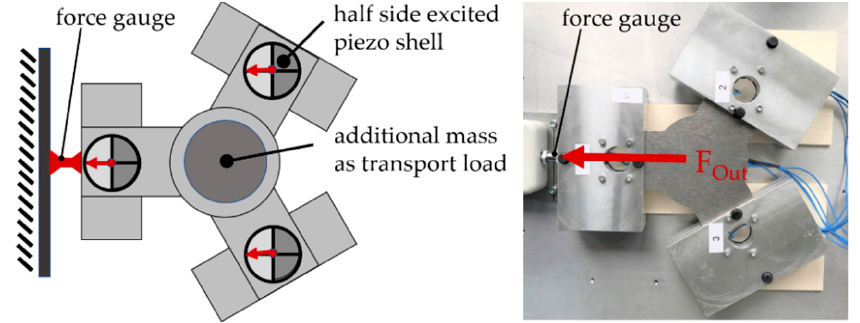
Figure 11. Setup for the output force measurements ( left side : schematic bottom view; right side : top view).